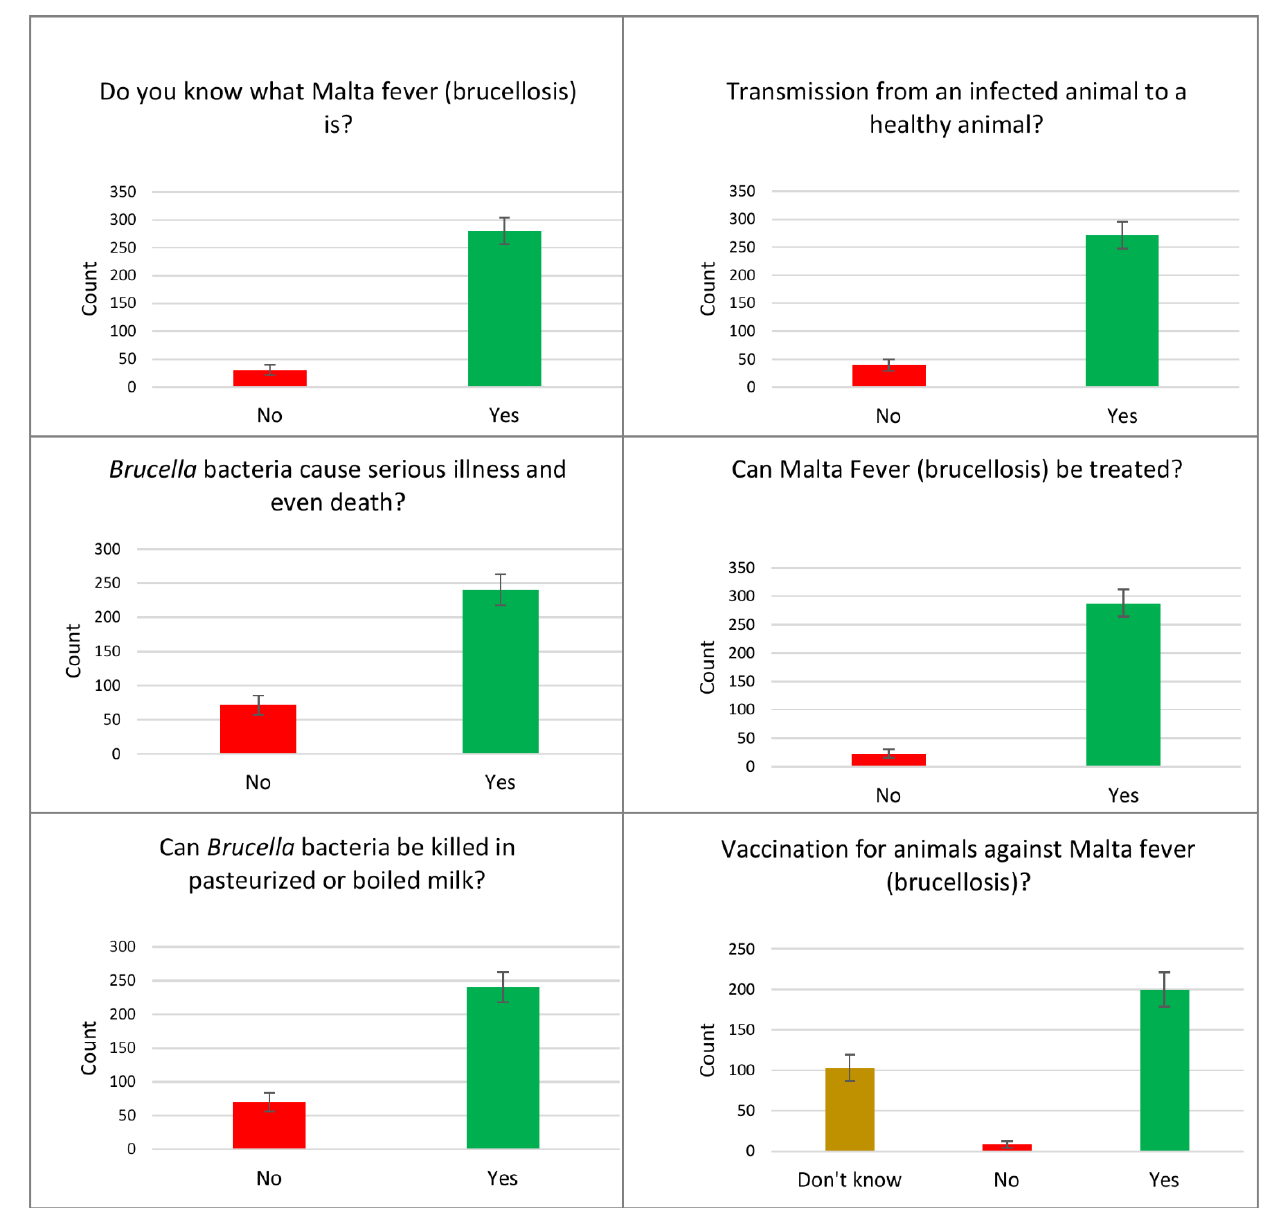
Figure 1. Items of awareness regarding brucellosis among parents in the Aseer region, southwestern Saudi Arabia.